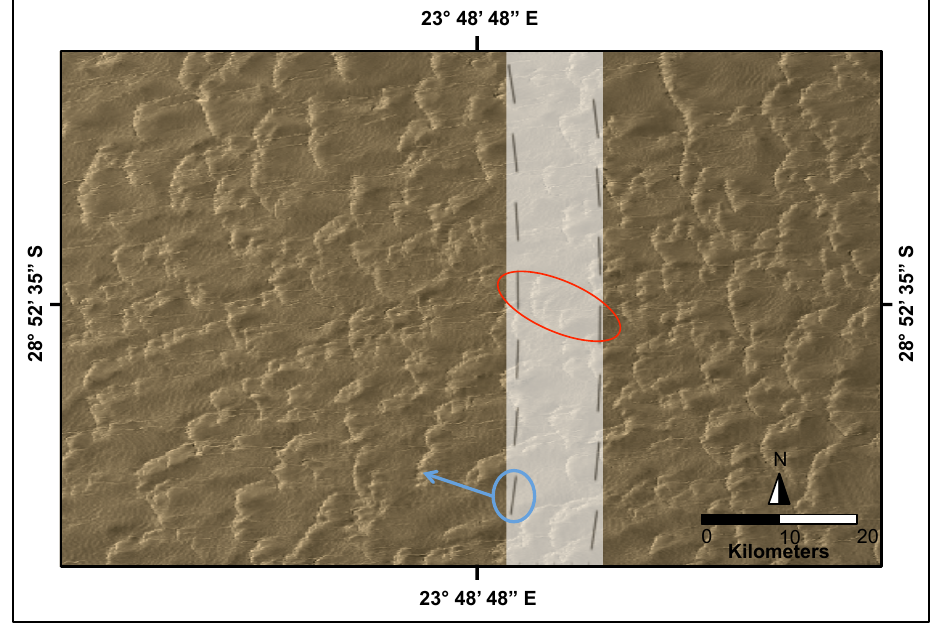
Figure 10. Synthetic Libya 4 landscape developed to illustrate the impact of in-scene variability on side slither relative calibration process. The red oval highlights the 2 center arrays of OLI. The blue circle highlights an edge array and its orientation with respect to significant features in the landscape when imaging in side slither mode.